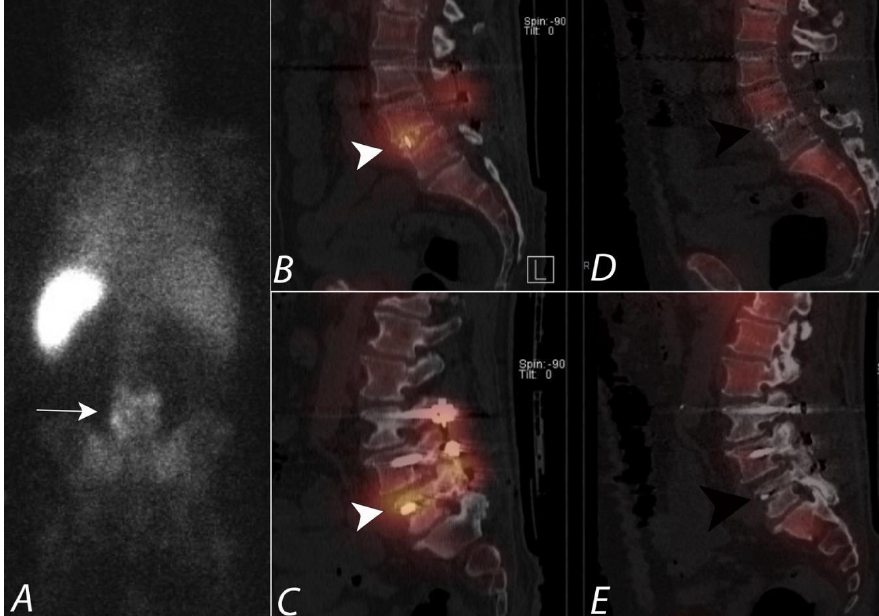
Figure 13. Seventy-two-year-old male with draining posterior lower lumbar wound one month after dorsal decompression and bilateral dorsal fixation from L3 to S1. Posterior planar image from an 111 In leukocyte (WBC) scan ( A ) demonstrates heterogeneous uptake of tracer activity localizing to the lower lumbar region (white arrow). Sagittal SPECT/CT images of the 111 In WBC scan ( B , C ) show increased uptake of labeled WBCs in the soft tissues, posterior elements, disc space, and vertebral bodies at L4-5. (white arrowheads). However, sagittal SPECT/CT images from 99m Tc sulfur colloid scan ( D , E ) demonstrate no focal uptake (black arrowheads) and is incongruent with the 111 In WBC distribution of activity. This supports that a pyogenic infection is present involving the L4-5 vertebrae, posterior elements, and disc spaces. The absence of uptake on sulfur colloid confirms that the uptake of WBCs is not due to a granulation tissue due to mononuclear cell infiltration in chronic